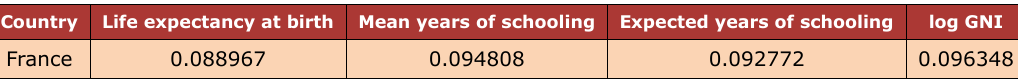
Table 3. Sample Normalized Decision Matrix